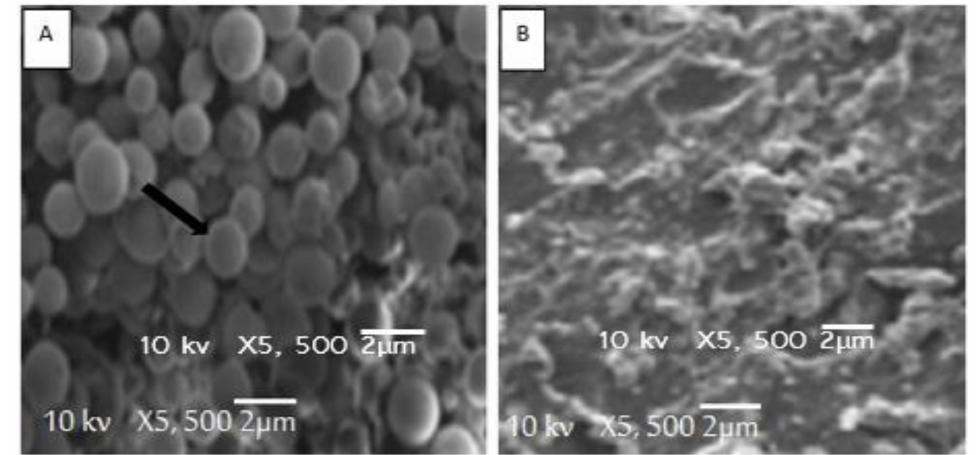
Figure 6. Scan electron microphotographs of untreated ( A ) and treated ( B ) Candida albicans.